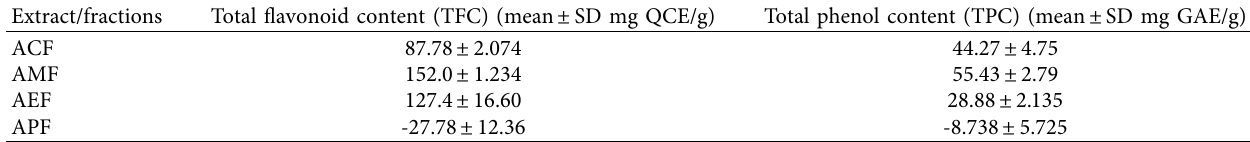
Table 2: Total phenolic and flavonoid contents of A. macrostachya extract and fractions. Extract/fractions